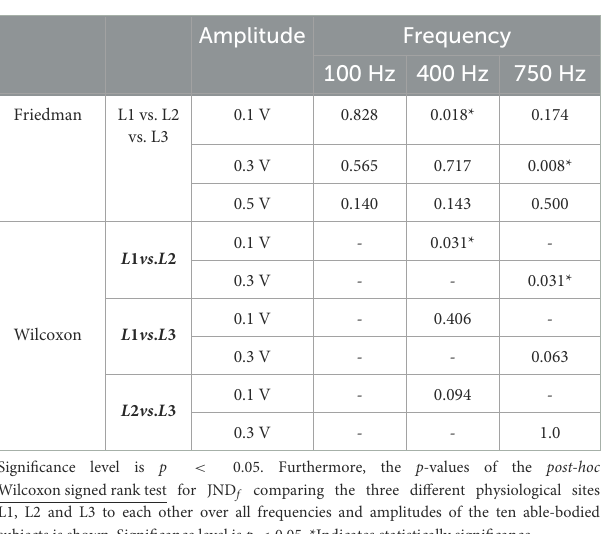
TABLE 3 The p -values of the Friedman for JND a comparing the three different physiological sites L1, L2, and L3 at all frequencies and amplitudes of the ten able-bodied subjects (SA) is given.